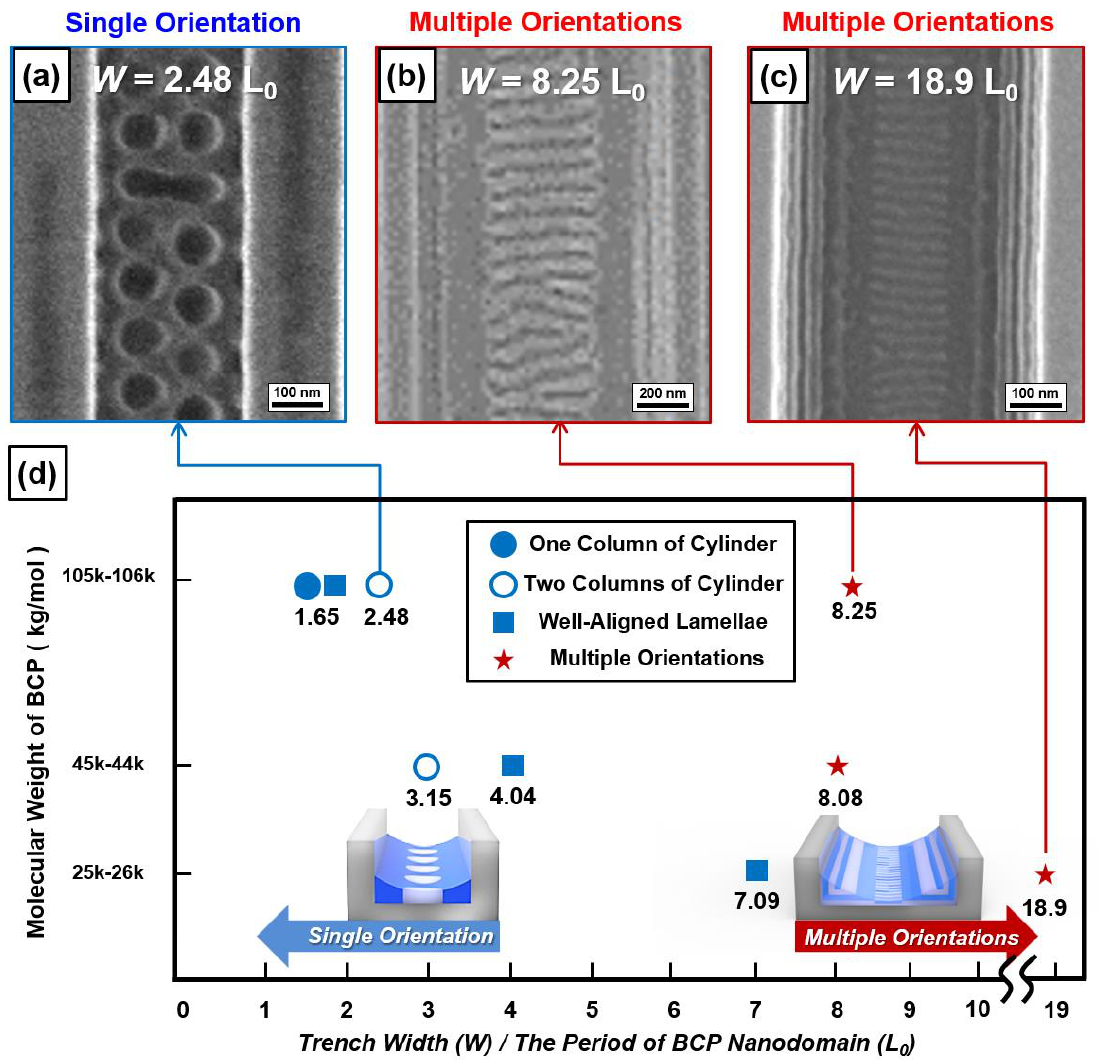
Figure 4. Top-view SEM images of lamella-forming BCP nanodomains inside various silicon trenches when ( a ) W = 2.48 L 0 , ( b ) W = 8.25 L 0 , and ( c ) W = 18.9 L 0 . ( d ) Morphology mapping for PS- b -PMMA (M n = 105 – 106, 44 – 45, and 25 – 26 kg/mol) nanodomains inside various silicon trenches.